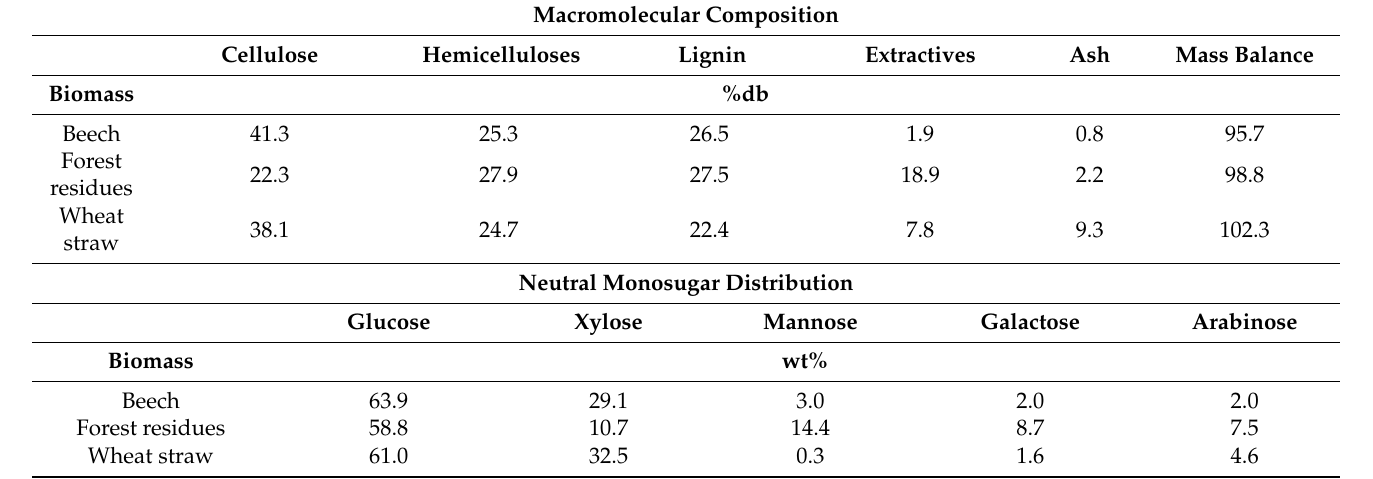
Table 1. Biomass macromolecular